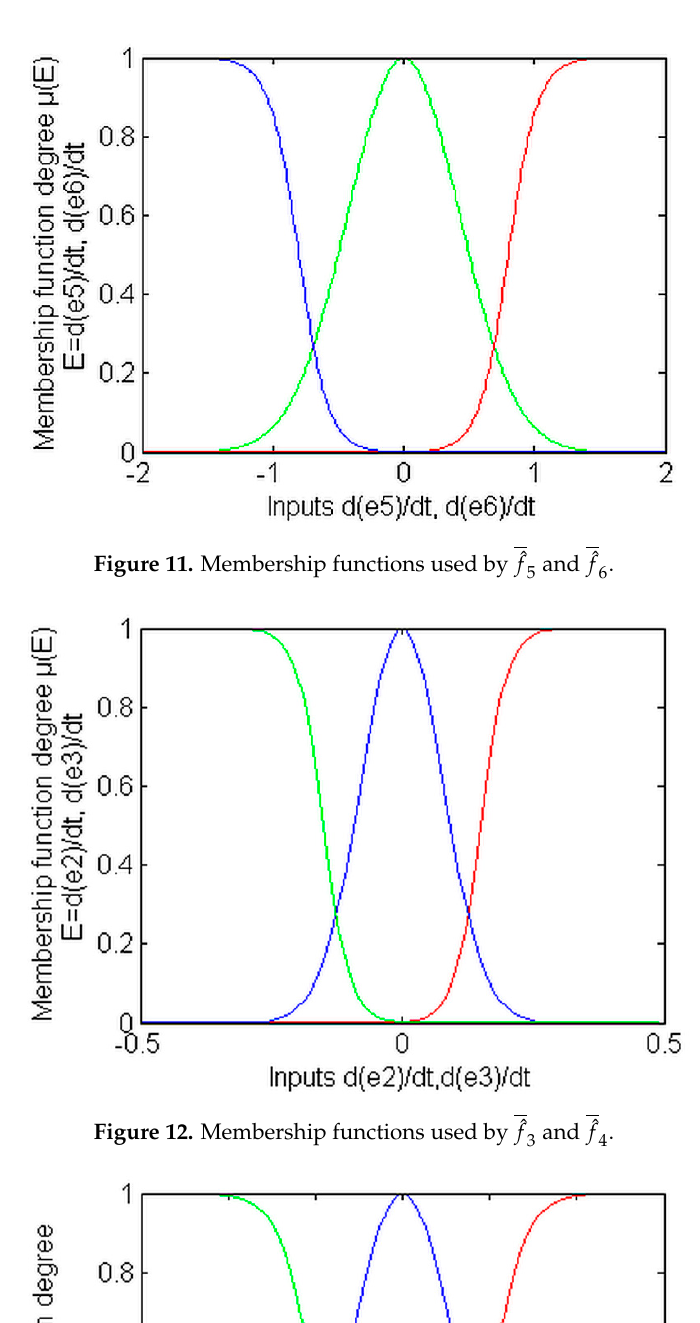
Figure 12. Membership functions used by ˆ f 3